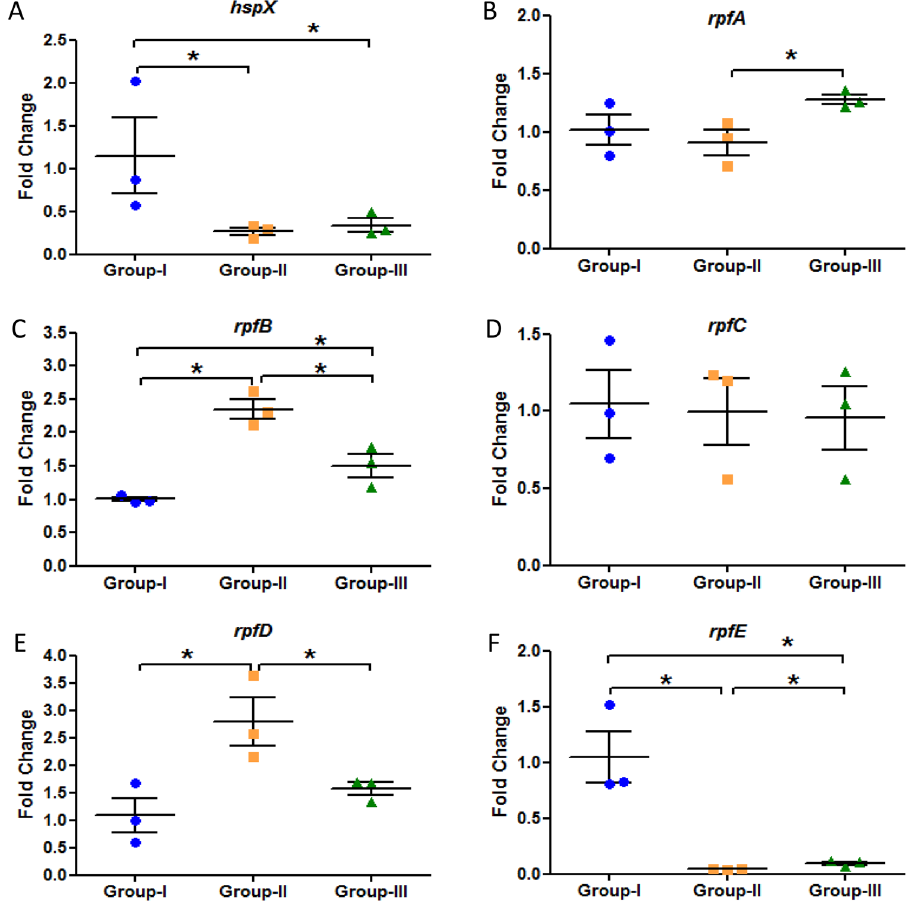
Figure 4. Expression analysis of various genes in the lungs of Group-I, Group-II and Group-III mice after 13 weeks of streptozotocin treatment. Gene expression of ( A ) hspX ( B ) rpfA ( C ) rpfB ( D ) rpfC ( E ) rpfD ( F ) rpfE . The data were represented as Mean ± SE of 3 animals in each group and the statistical significance was determined by Mann–Whitney test. *p ≤ 0.05. Group-I: latent tuberculosis only, Group-II: latent tuberculosis with diabetes and Group-III: latent tuberculosis with immunosuppression. Animal model was developed only once but gene expression was studied in triplicates from each